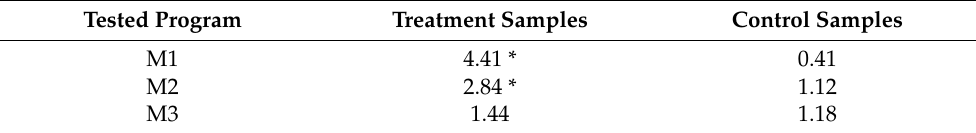
Table 3. Observed t -values. Tested